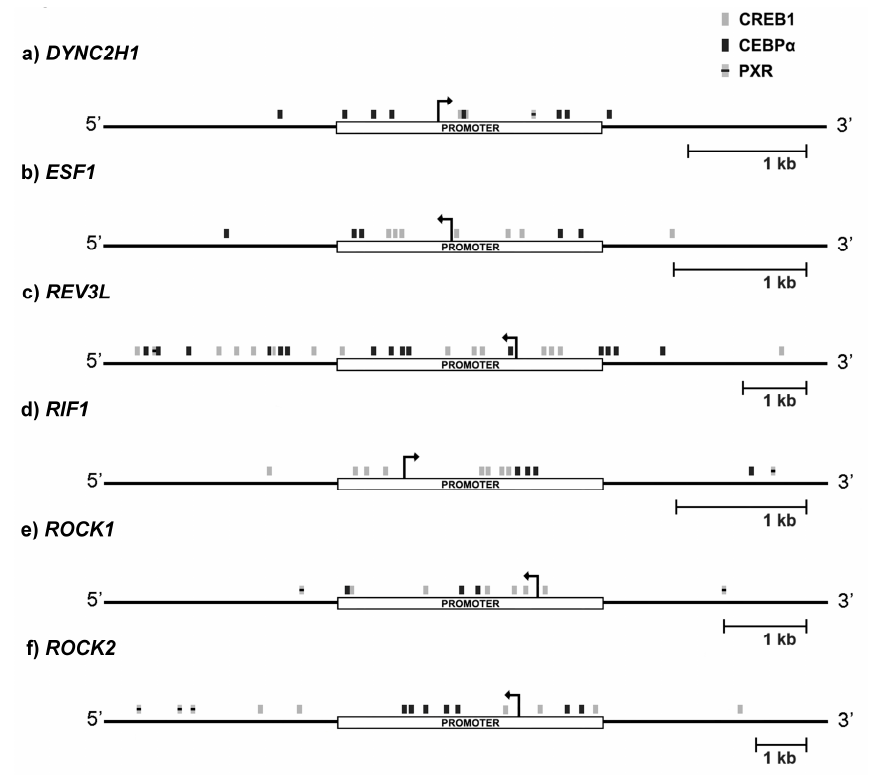
Figure 4. In silico analysis of the regulatory region of the genes up-regulated by 3 α -THP. Six of the validated genes were analyzed for their promoter regions and scanned for putative transcription factor binding sites with several bioinformatic tools: JASPAR, UCSC Genome Browser, UGENE, and TRANSFAC. For each gene, a white rectangle indicates the promoter region, and the continuous black lines represent the adjacent regulatory region. Black arrows indicate the transcription start site and the gene transcription direction. The putative binding sites for CREB1 (grey box), CEBP α (black box), and PXR (black lined grey box) are denoted. According to each gene, the scale bar of 1 kb is defined.